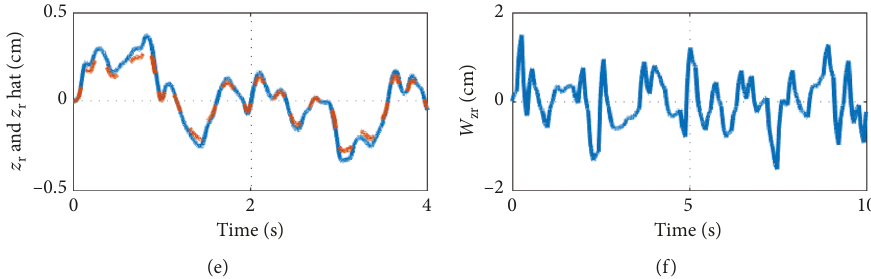
Figure 12: The real states (solid line) and estimated states using SPKF (dotted line) in the case of 5km/h. (a) z dt hat. (c) z w and z w hat. (d) dz w / dt and dz w / dt hat. (e) z r and z r hat. (f) w